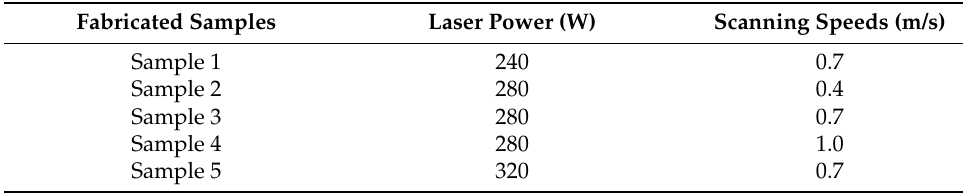
Table 4. The PBF conditions used for the samples in the Shibata et al. study [114]. Fabricated